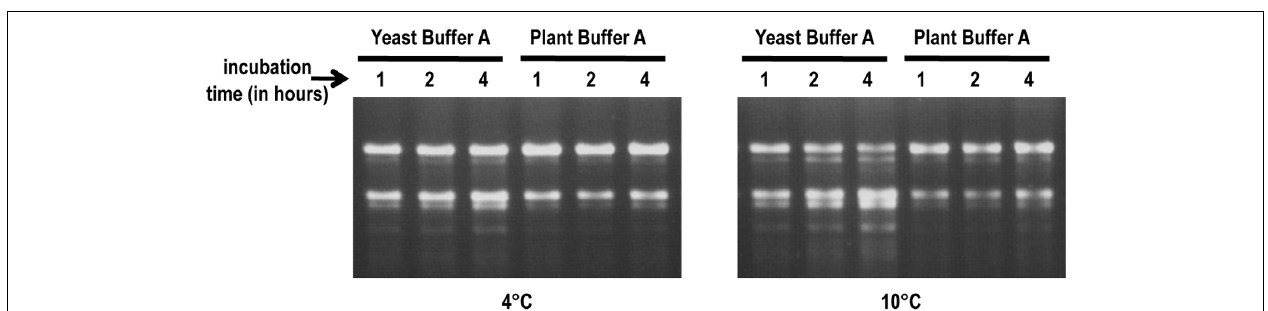
of the large-scale plant ribosomal preparation from Arabidopsis protoplasts: 80S 1st spin (left panel) and sw 80S (right panel).Three different concentrations (0.5, 0.75, 1 pmol) were loaded for each panel. (C) Sucrose-gradient separation of plant 40S and 60S ribosomal subunits. After centrifugation, the first 1.5 ml of the gradient were removed from the top of the tube and discarded.The remaining sucrose gradient containing subunits was subdivided into 0.5 ml fractions. Each fraction (4 ml) was resolved on a 1.2%, 0.5 × TBE agarose gel for detection of rRNA from 40S and 60S subunits in situ (left panel). Fractions containing 40S and 60S subunits were combined into two pools. After buffer exchange and sample concentration, 2 μ l of each pool were loaded onto the agarose gel to inspect the quality of the rRNA (right panel).